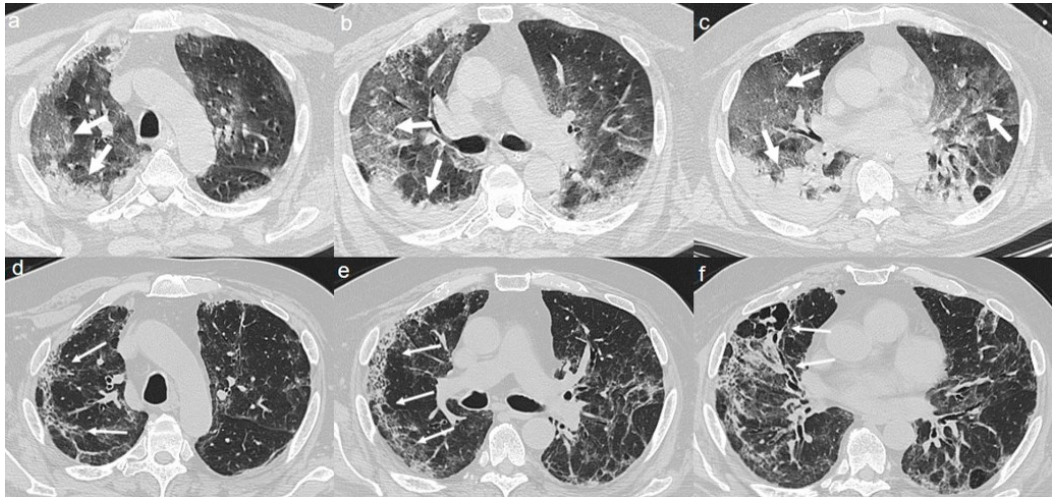
Figure 7. ( a – c ) CT shows bilateral extensive areas of GGO and consolidations, with prevalent peripheral distribution, in upper and lower lobes (arrows). ( d – f ) Follow up CT 4 months after admission shows persistence of diffuse thickening of the interlobular septa, with fibrotic appearance (thin arrows in d , e ); air bubble sign with bronchiectasis (thin arrows in f ) is recognizable.